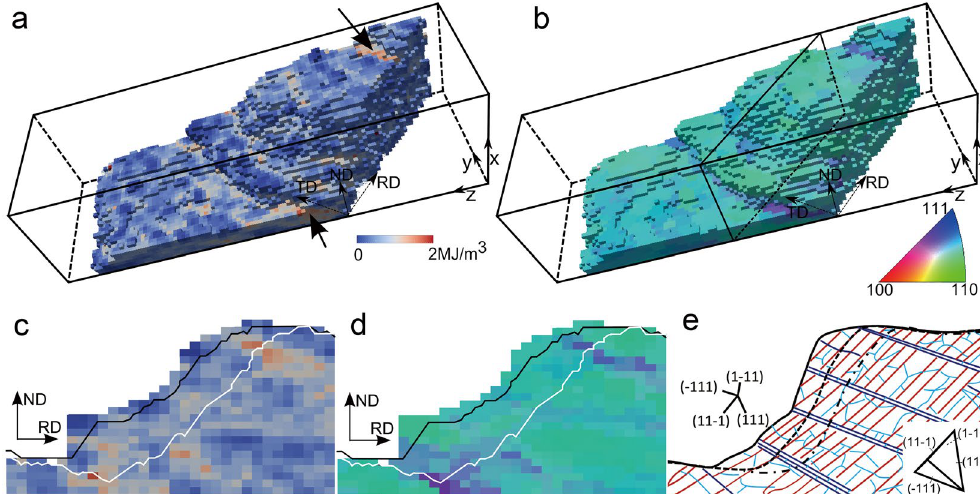
Figure 4. Effects of the deformation microstructure on the local boundary migration. The deformation matrix at the initial stage colored according to the local stored energy ( a ) and local misorientation rotation axis ( b ). ( c ) and ( d ) show a cross-section view of the microstructure at the position marked in ( b ). Black and white lines mark the boundary positions after the two annealing steps. ( e ) Sketch drawn based on the 3D X-ray data and 2D data from electron microscopy showing the microstructure and the boundary traces. The blue and red lines represent the two sets of intersecting dislocation boundaries, while the light blue lines represent incidental dislocation boundaries, all of which are typically observed in deformed aluminium at strains similar to that of the present sample 28 . The black solid, dashed and dot dashed lines represent the three recrystallization boundary positions. The traces of the four {111} planes and the projection of a {111} tetrahedron for the deformed grain on the RD-ND section are also